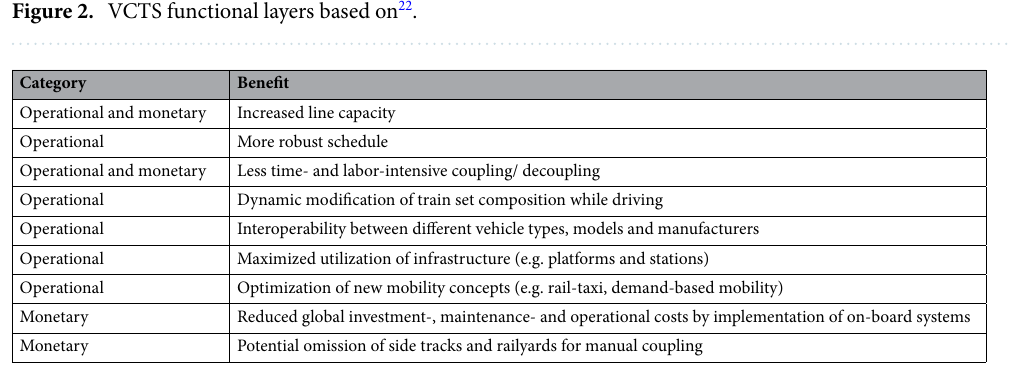
Table 1. Potential benefits of VCTS over conventional